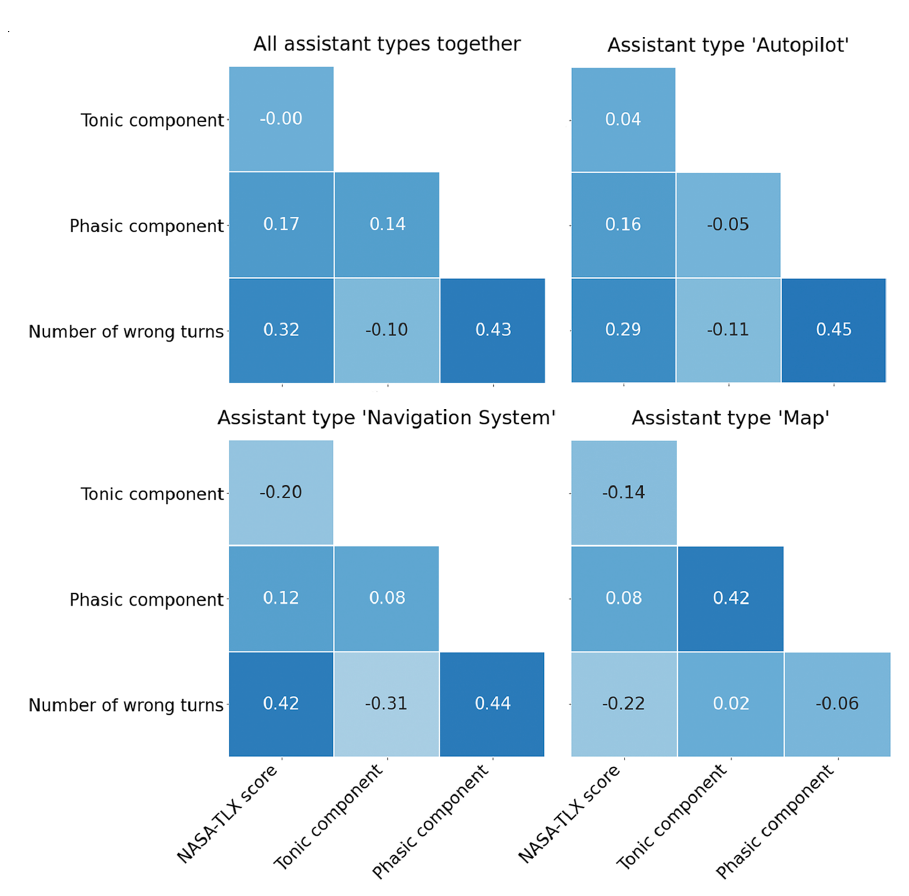
Figure 7. Correlation analysis. Top left: test phase including all assistant types. Top right : test phase for assistant type ‘Autopilot’. Button left : test phase for assistant type ‘Navigation System’. Button left : test phase for assistant type